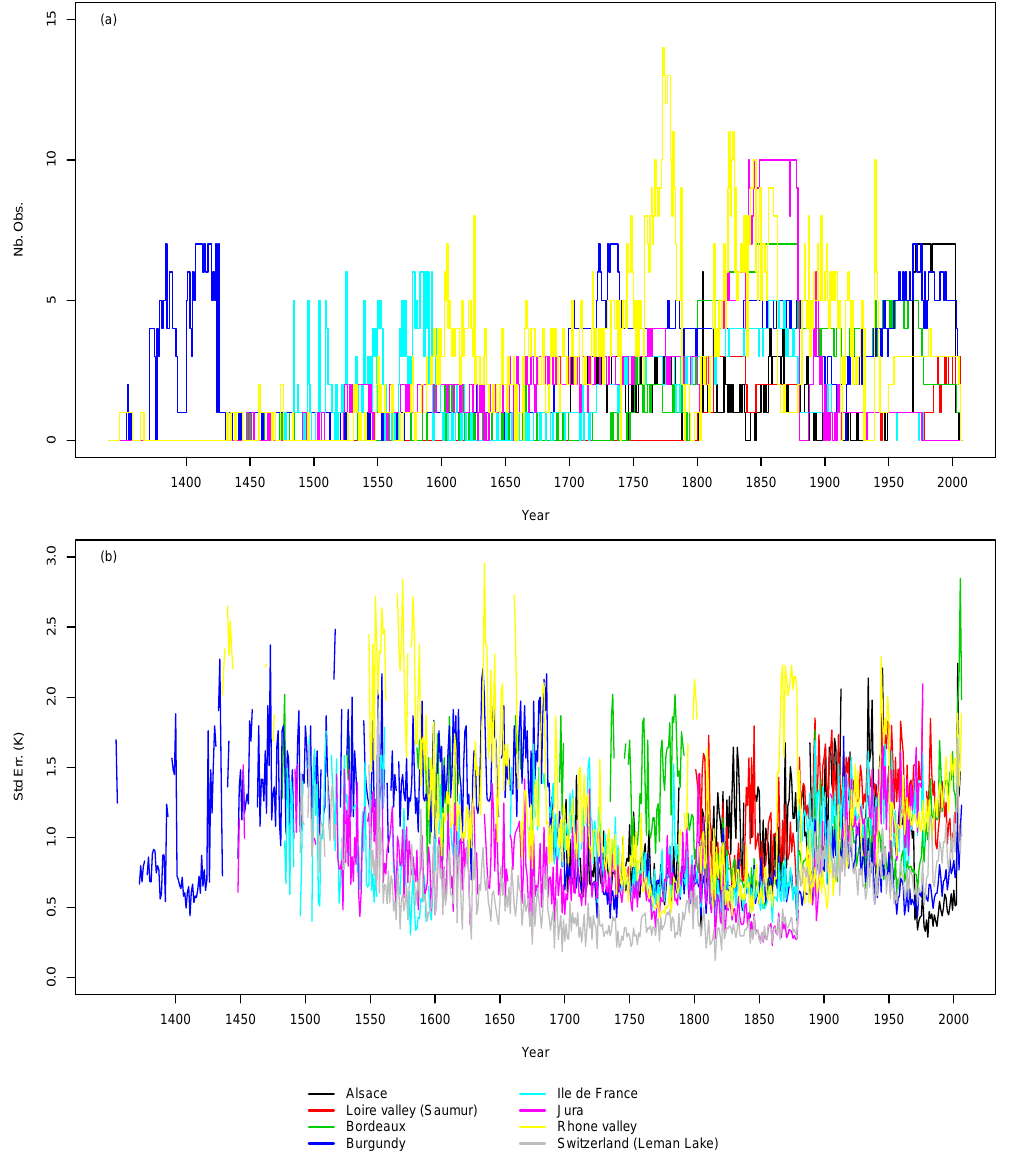
Fig. 1. (a) Number of observations for each viticulture region and for each year. (b) Standard error of the temperature reconstruction for each viticulture region, taking into account the standard deviation within regions and the number of available